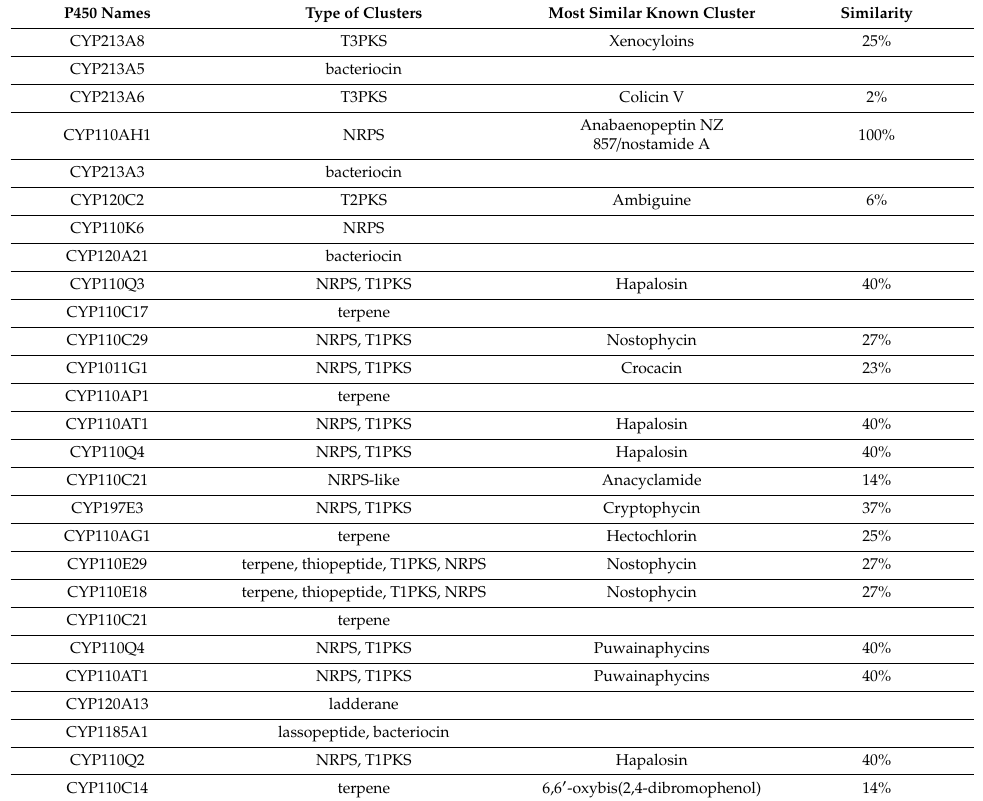
Table 3. Comparative analysis of P450s that are associated with secondary metabolites biosynthetic gene clusters (BGCs). Types of clusters, most similar known cluster and similarity were obtained by submitting individual P450 clusters to anti-SMASH (antibiotics & Secondary Metabolite Analysis Shell) [65]. Standard abbreviations representing type of clusters as indicated in anti-SMASH [65] were used in the